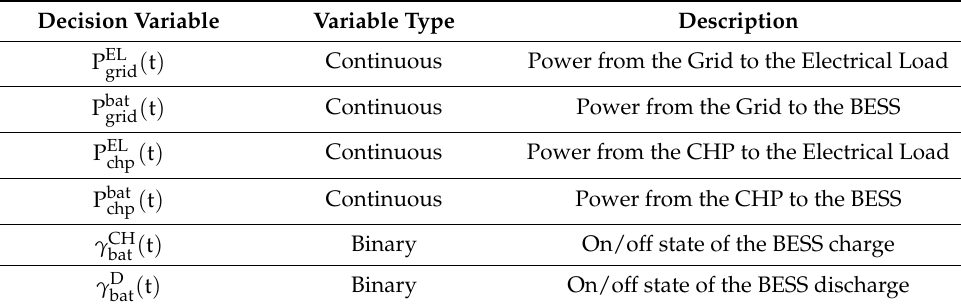
Table 1. MILP economic dispatch continuous and binary decision